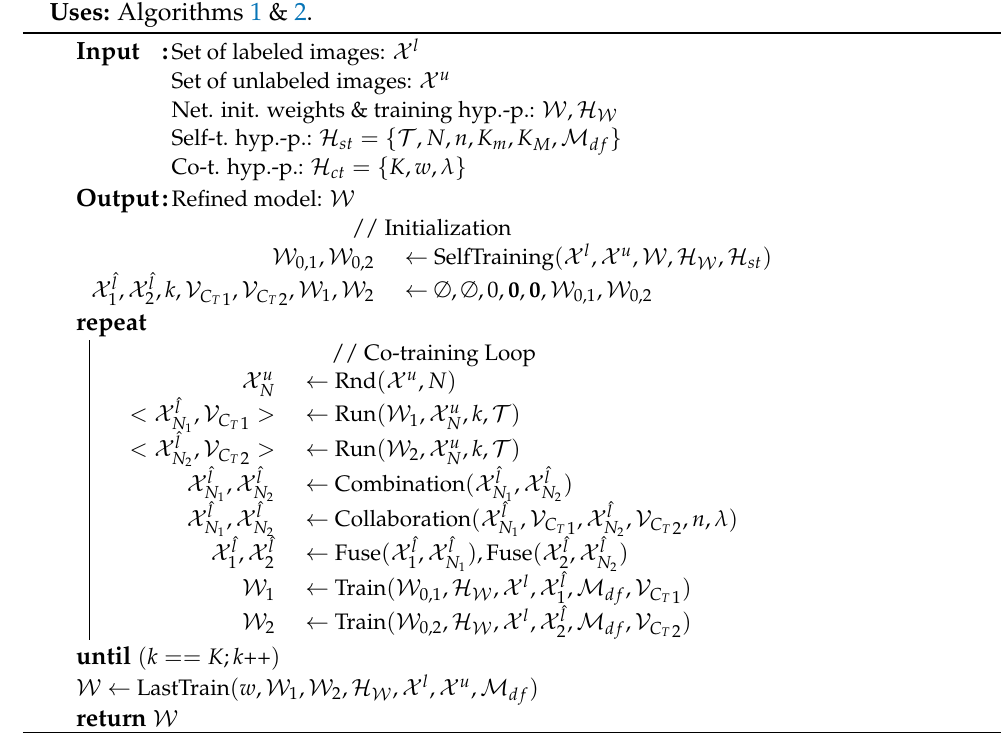
Algorithm 3: Co-training